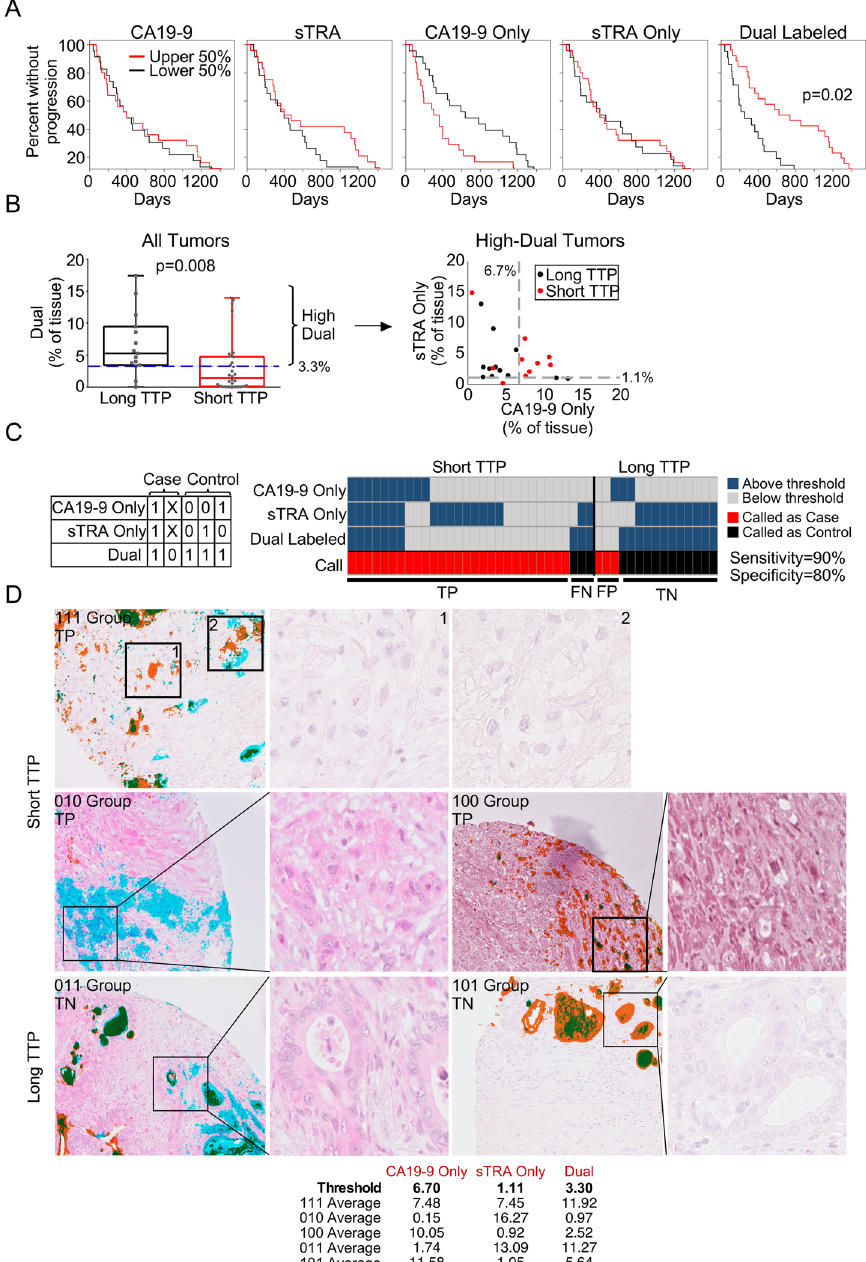
Figure 6. Associations between glycan type and time-to-progression (TTP). ( A ) We divided the patients into the upper and lower halves of expression of each of the five indicated marker types, and then separately plotted Kaplan-Maier curves for each. ( B ) The tumors with long TTP ( > 2 years) had significantly higher (p = 0.008, Wilcoxon rank sum test) dual-marker expression than the patients with short TTP. Among just the tumors with high dual-marker expression, only tumors with short TTP had high levels of both the sTRA-only and CA19-9- only markers. The dashed lines indicate the threshold for each marker, and the value of the threshold is given. ( C ) Patients that were high in all three of the indicated markers, or that were low in the dual marker, were called as cases (short TTP) and all other patients were called as controls (long TTP). The table shows the rules for the calls. A ‘1’ indicates the marker is above its threshold, ‘0’ indicates below threshold, and ‘X’ indicates either above or below. TP, true positive; FN, false negative; FP, false positive; TN, true negative. ( D ) We present H&E images both with and without overlaid signal. The colors for the overlays are the same as in Figs 3–5. A frequent observation among short-TTP patients with high levels of all three markers (top row) or low levels of the dual markers (middle row) was scattered groups of poorly-differentiated cells labeled either with sTRA or CA19- 9. A common feature among long-TTP patients (bottom row) was moderately- or well-differentiated PDACs without scattered groups of single-labeled cells. The table provide the averages over all regions for each of the tumors in panel